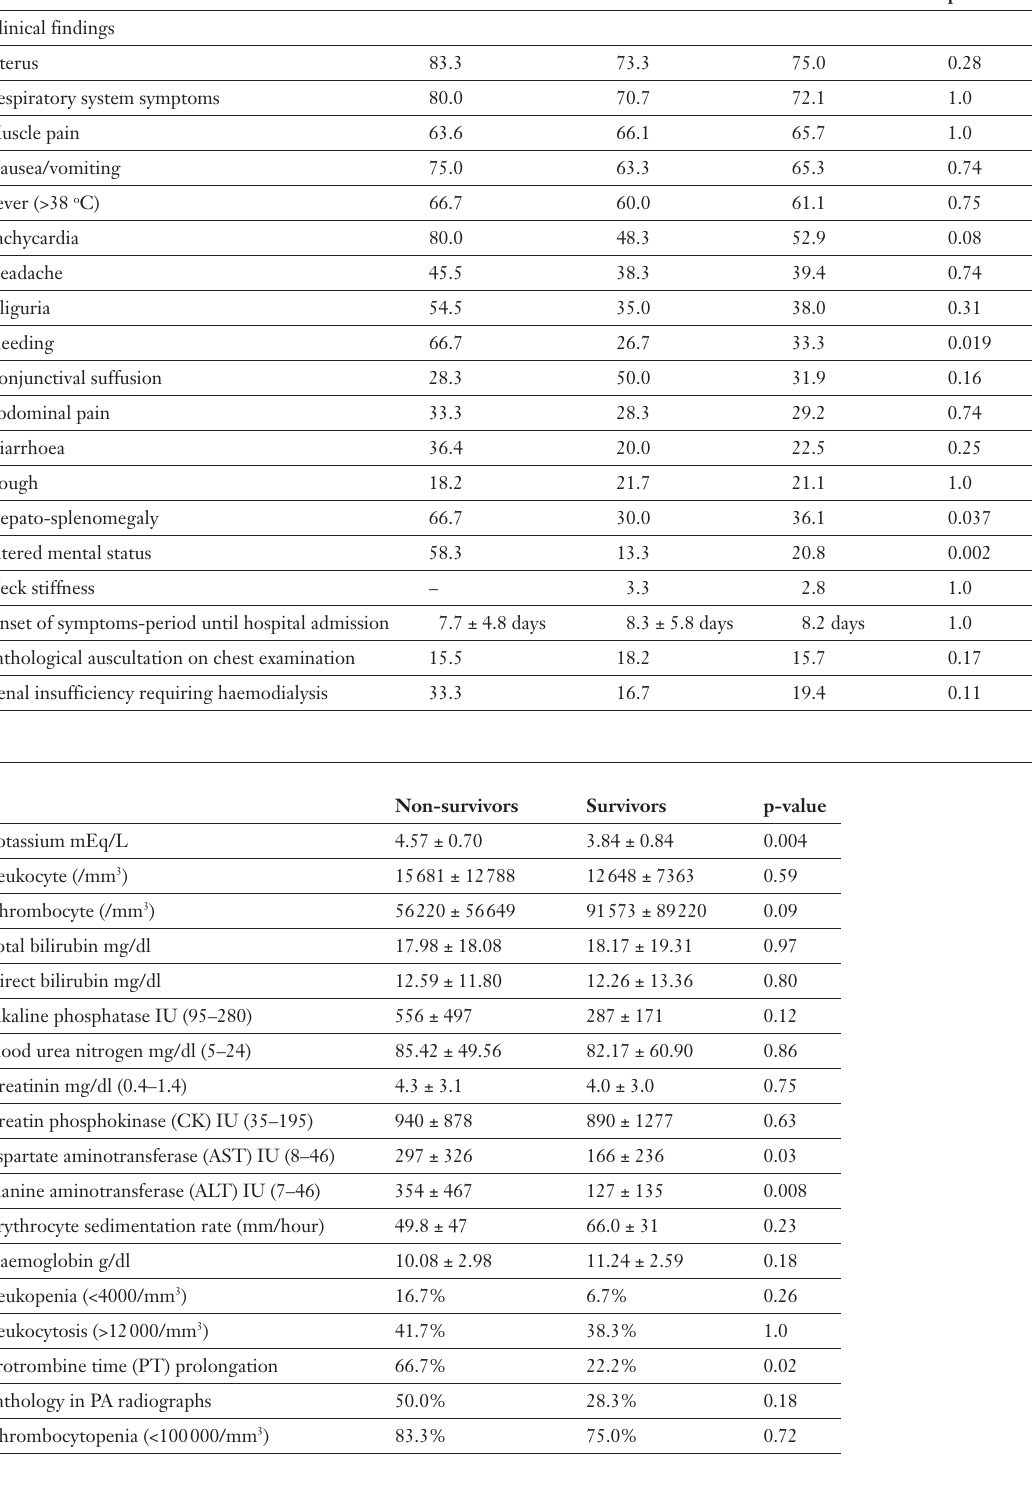
Clinical findings of patients.